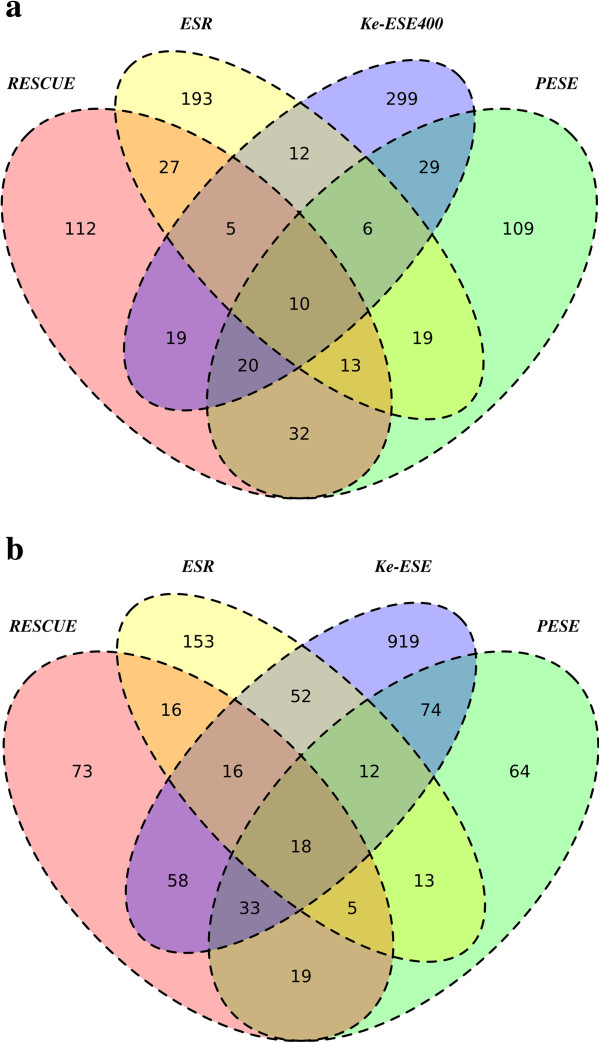
Venn diagram showing overlap between datasets in hexamers identified as possible ESEs (a) using Ke-ESE400 and (b) Using Ke-ESE. The great majority of ESEs are unique to any given dataset. For example, 47.06%, 45.80%, 67.72% and 74.75% are motifs unique to for RESCUE, PESE, ESR and Ke-ESE400, respectively.